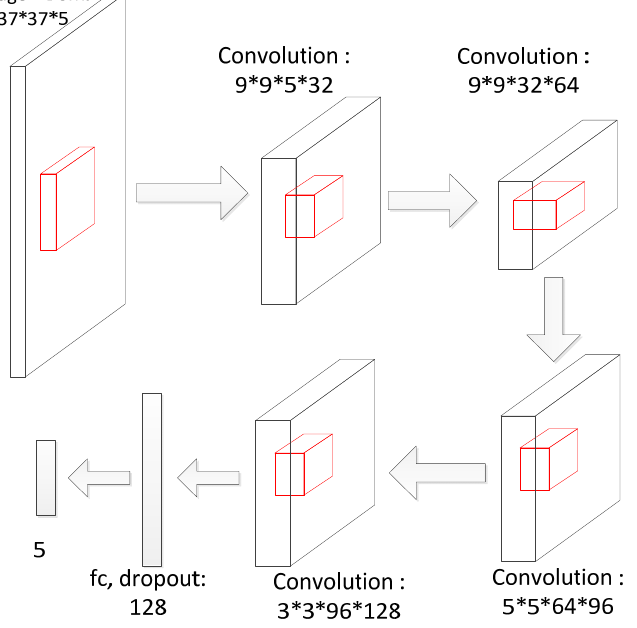
Figure 2. An illustration of the CNN architecture taking the example when the patch size is 37 pixels with all the data sources included. The network consists of five layers (four convolutional layers and one fully-connected layer) with a final 5-way soft-max loss